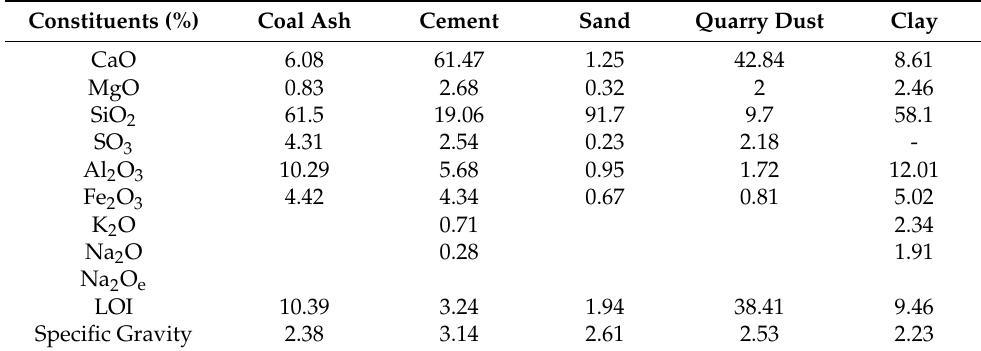
Table 1. Chemical compositions of coal ash, cement, sand, quarry dust, and clay.